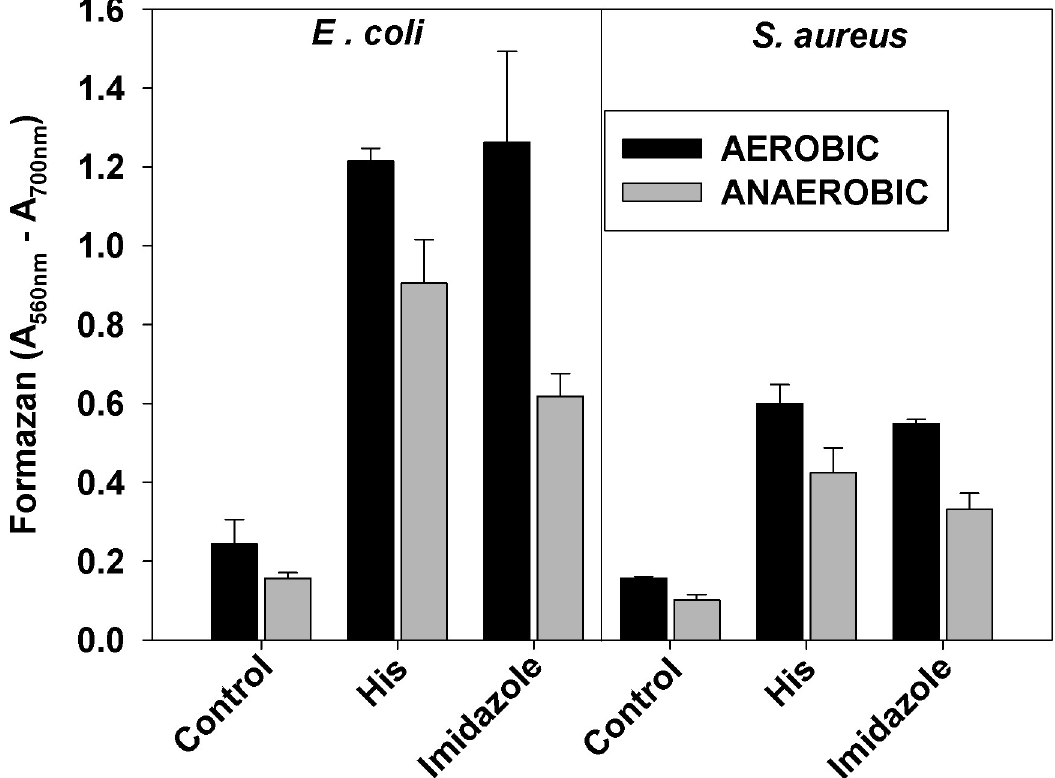
Fig 4. Effect of growth conditions on the increase of formazan production by histidine and imidazole. Mid-log E . coli and S . aureus cultures grown aerobically or anaerobically in LB and BHI media, respectively, were washed and diluted in PBS/glucose to OD 600 nm = 0.1. Histidine or imidazole were added to a final concentration of 5.0 mM, followed ten minutes later by addition of MTT (0.5 mg/ml). Samples were incubated 60 min at 37˚C in a 96-well plates with shaking. At the end of the incubation period, SDS was added, and after 60 min of incubation, absorbance was measured at 560 nm and 700 nm (background). The average of the difference A 560 nm -A 700 nm of two separate experiments, each sample run in triplicate, ± SD is presented.